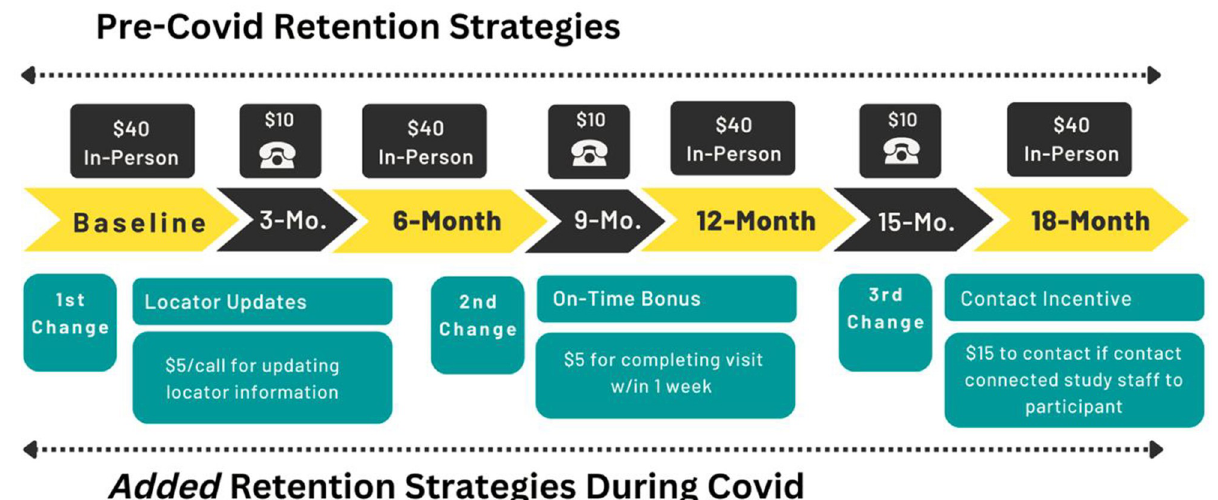
Fig 1. Study assessment schedule and retention